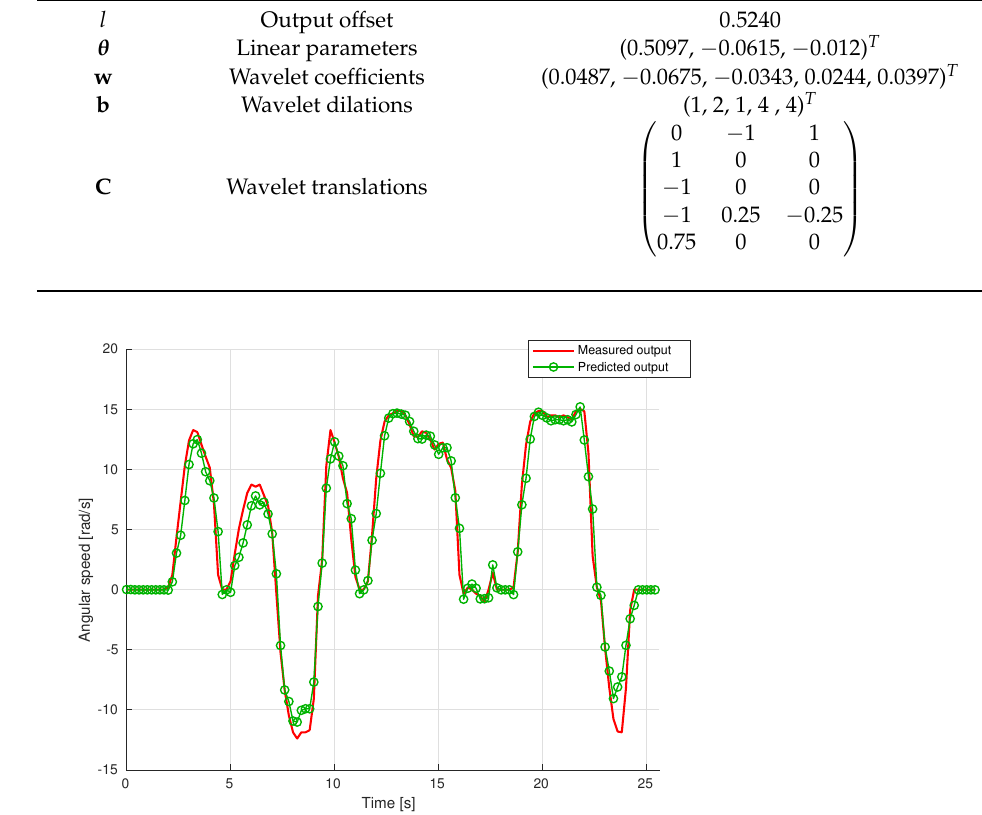
Figure 4. Comparison between measured output (red line) and WANARX model predicted output (green